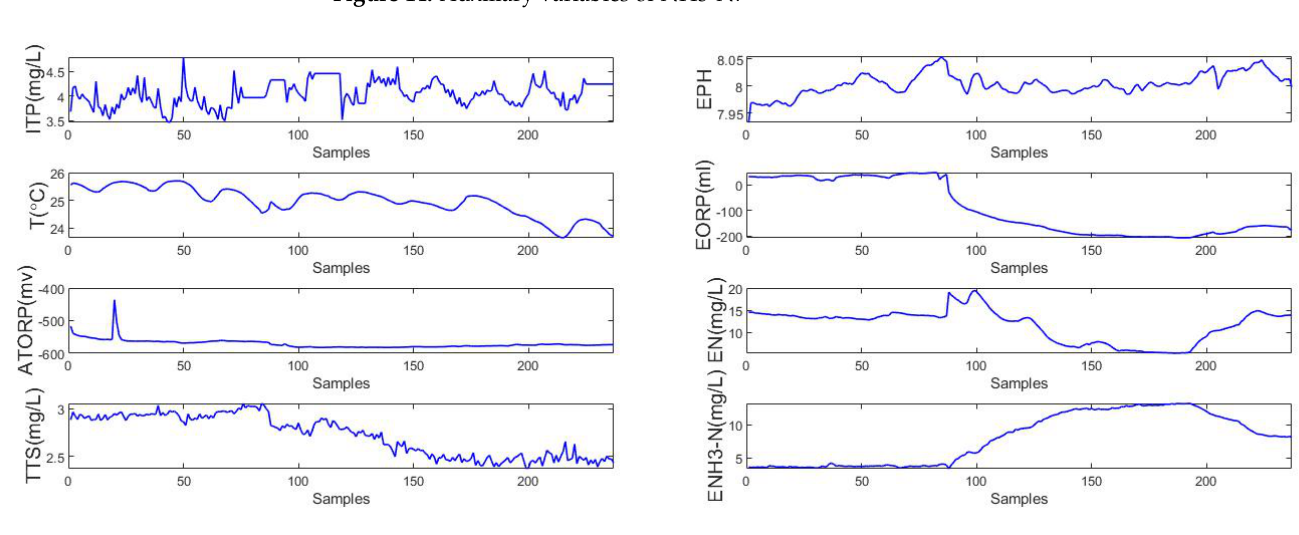
Figure 14. Auxiliary variables of NH3-N.